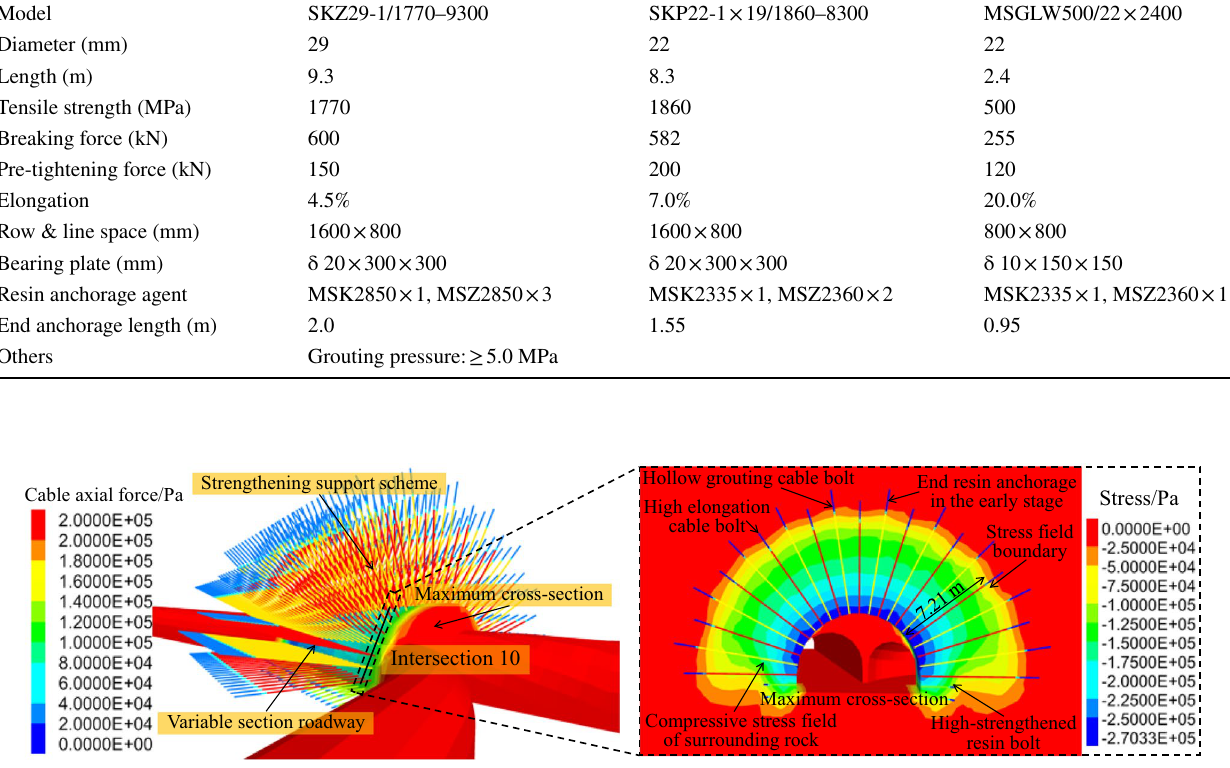
Fig. 23 Roadway supporting structure and surrounding rock compressive stress